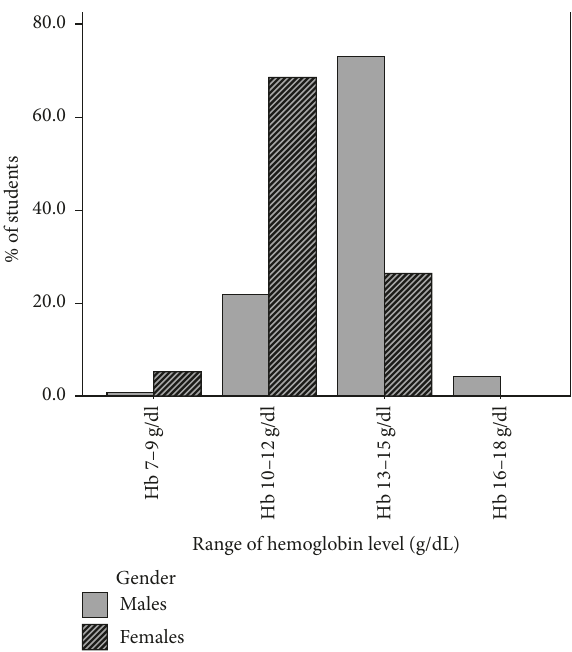
Figure 1: Percentage of hemoglobin concentrations for male and female